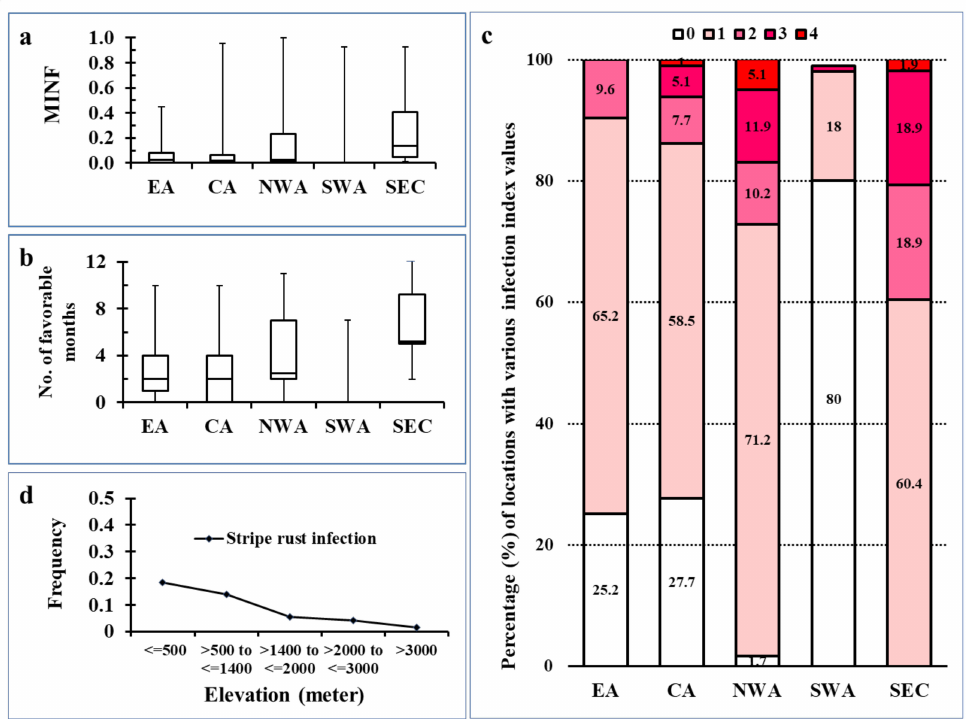
Figure 1. Normalized monthly infection index (MINF), Fav-month, and environmental suitabil- ity scores for the stripe rust pathogen ( Puccinia striiformis f. sp. tritici ) infection on barberry in Asian and adjacent Southeastern European regions. ( a ): boxplot for MINF values; ( b ): boxplot for numbers of favorable months; ( c ): frequencies of locations in different elevation intervals; and ( d ): percentages of locations with suitability scores in various regions. EA = East Asia; CA = Central Asia; NWA = Northwest Asia; SWA = Southwest Asia; and SEC = Southeast European Countries. Suitability scores: 0 = no; 1 = low; 2 = moderate; 3 = high; and 4 = very